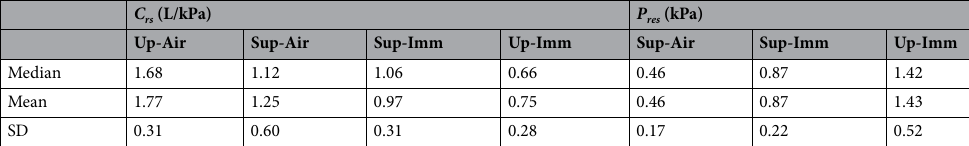
Table 3. Overall respiratory compliance ( C rs ) and restoration pressures ( P res ) measured. Individual values for each subject are available in “Supplementary Information” files. Median values are shown with mean and standard deviation. Statistical significance was determined using Friedman’s test (4 conditions) and Dunn’s post-hoc test for comparisons between two conditions. Compliance of the overall respiratory system (combined lung and chest wall) ( Crs ): Friedman p < 0.001; Up-Air vs Sup-air: NS; Sup-Air vs Sup-Imm: NS; Up-Air vs Sup-Imm: p < 0.01; Sup-Air vs Up-Imm: p < 0.001; Up-Air vs Up-Imm: p < 0.001. Restoring pressure (P res ): Friedman p < 0.001; Sup-Imm vs Sup-Air: p < 0.05; Up-Imm vs Sup-Imm: p < 0.01; Up-Imm vs Sup-Air: p < 0.05.